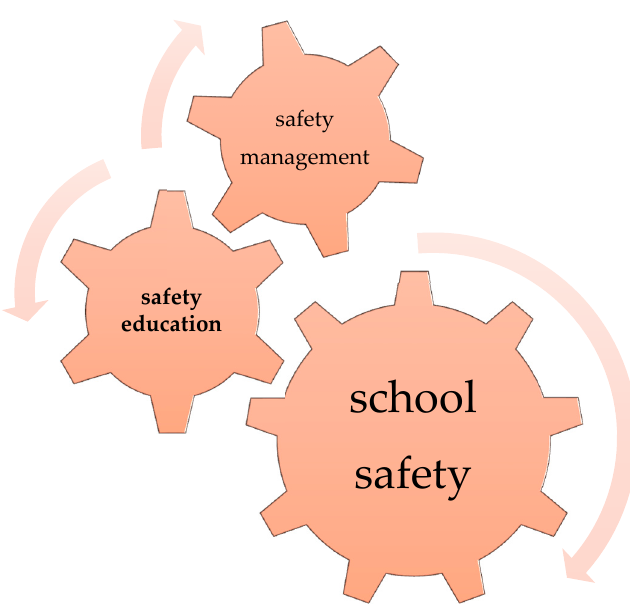
Figure 1. Basics of safety assurance in schools based on the school health and safety act.